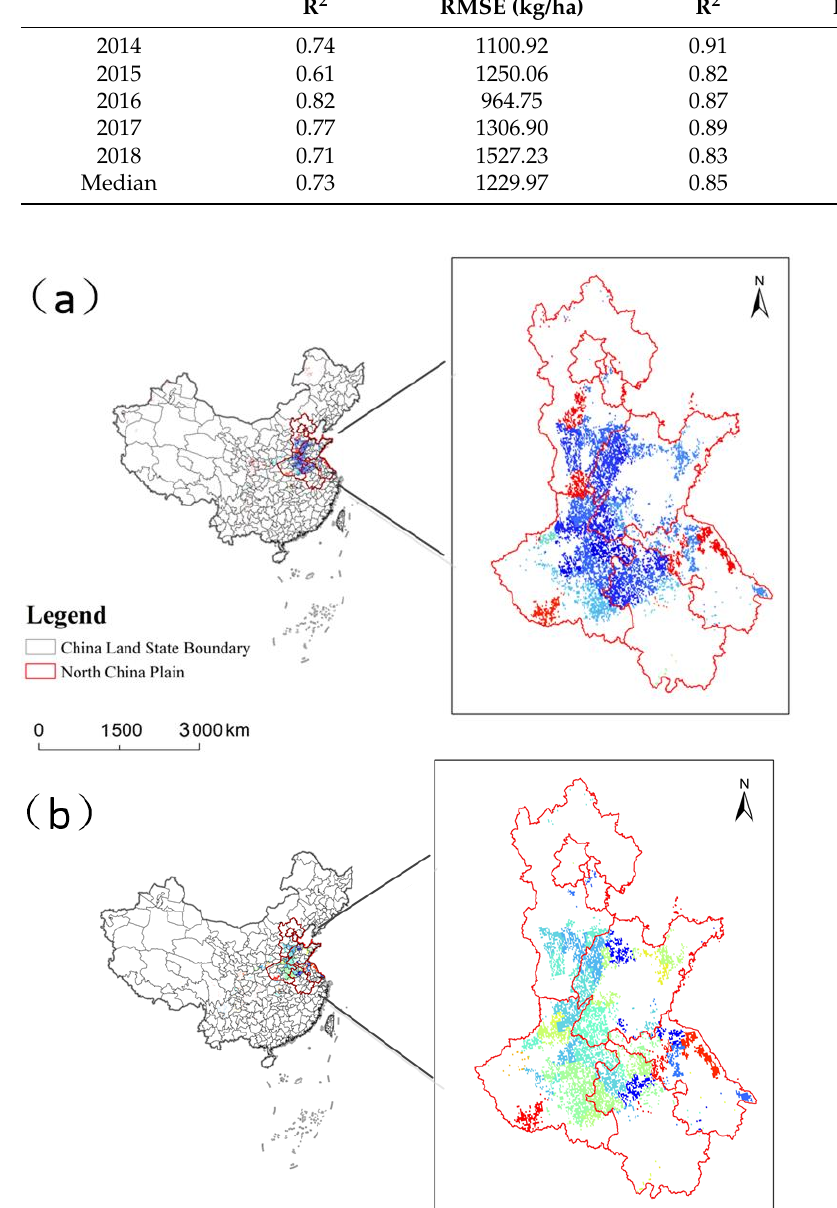
Figure 5. Spatial pattern of winter wheat yield forecast in 2014: ( a ) RF, ( b ) MLR, ( c ) actual yield 3.4. The Influence of Time Series Data on the Simulation Ability of the Model Since SIF has no advantage in large-scale yield estimation, EVI is used as an example in this experiment. The results (Figure 6) illustrate that the two models have the following similar characteristics: (1) for any particular inputs, the yield estimation accuracy of the model increases rapidly with the increase of acquired data and the growth rate slows down and gradually reaches saturation at a later stage of the growing season; (2) the com- bination can significantly improve the performance of the yield estimation model which can be significantly improved through combining climate data with satellite data, and cli- mate data plays an essential role in the model. However, there are significant differences in the trajectory of model prediction performance produced by different inputs. With only satellite data as inputs, the model generally starts from very poor performance (R 2 ~0.1– 0.2), and then it improves relatively by much (R 2 ~0.4–0.5), while with only climate data and combined data as inputs, the model starts with relatively good performance (R 2 ~0.4– 0.6) and has a small increase during the growing season. To understand more clearly the